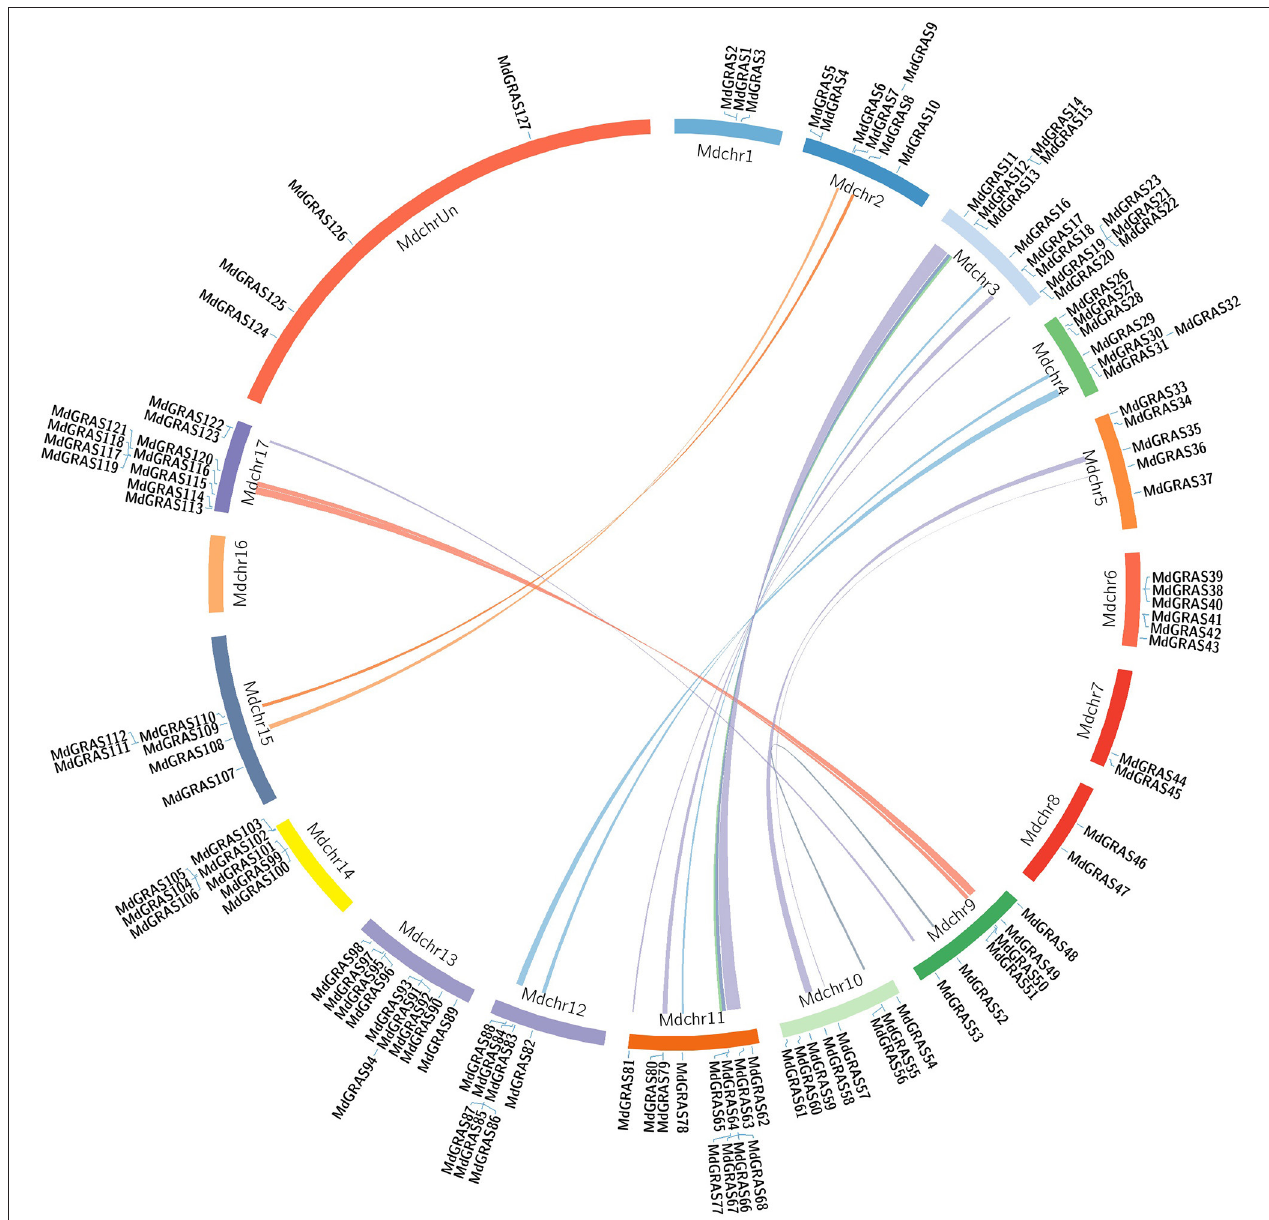
FIGURE 3 | Syntenic relationships of apple GRAS genes. Locations of MdGRAS genes on the apple